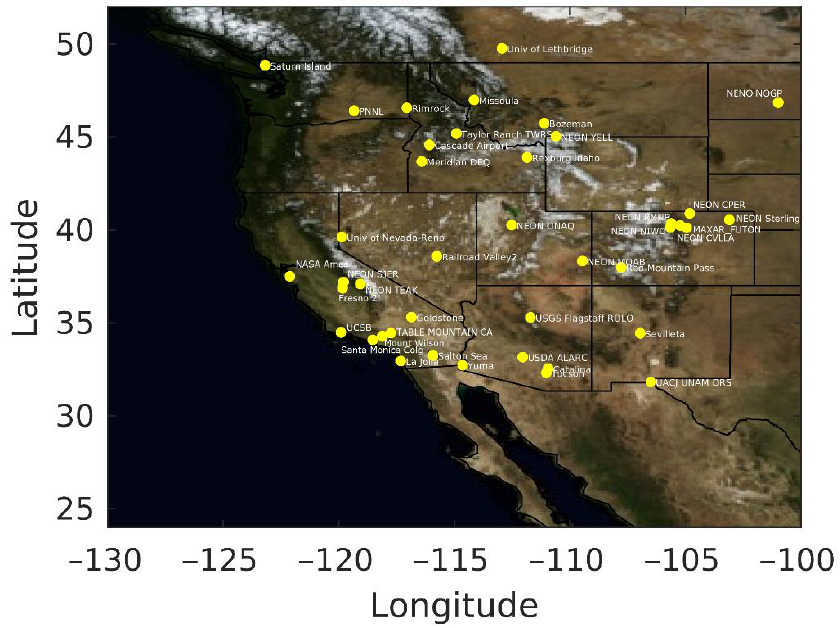
Figure 1. Map of the analysis domain and locations of the 41 AERONET sites (yellow dots). The names of these sites are labeled next to each location.